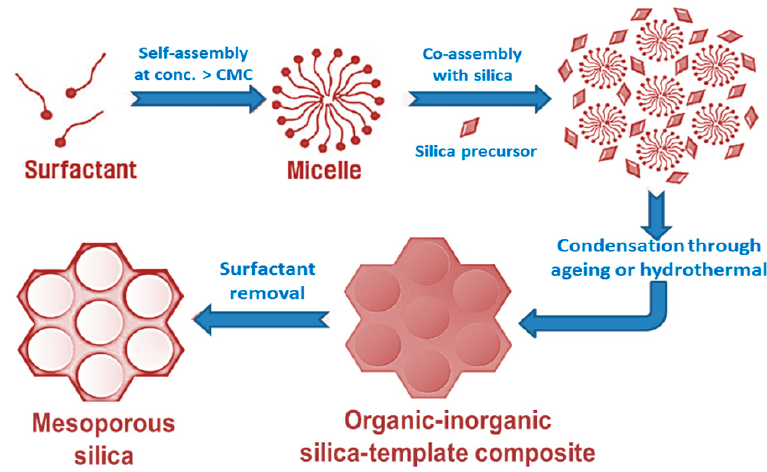
Figure 1. General synthesis strategy for mesoporous silica using a surfactant-templated route.